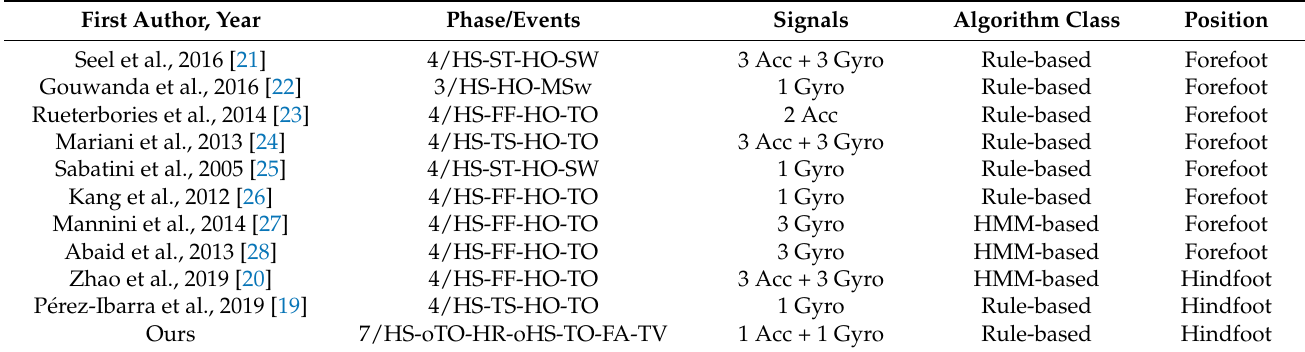
Table 1. Existing studies on gait phase